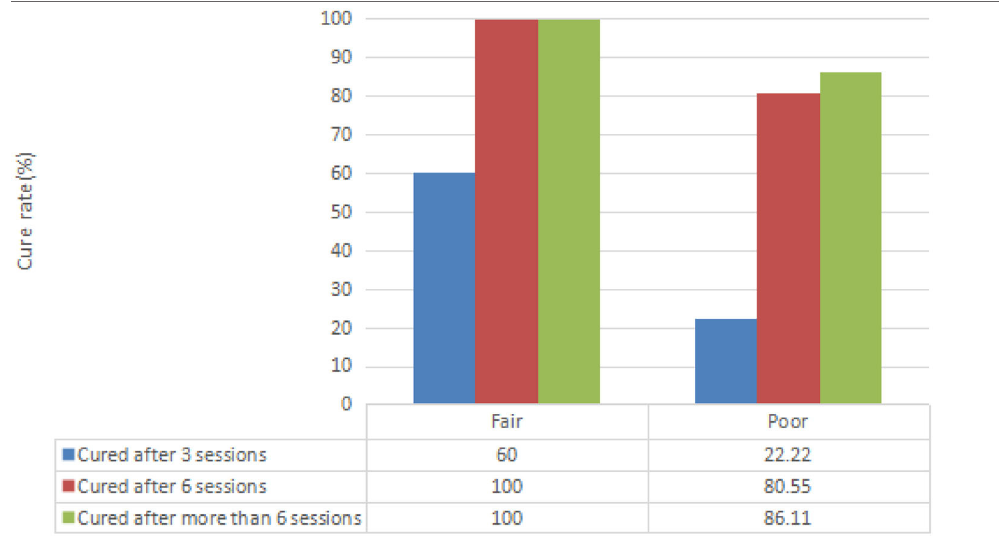
TABLE 5 | The cure rate of different degree of fecal